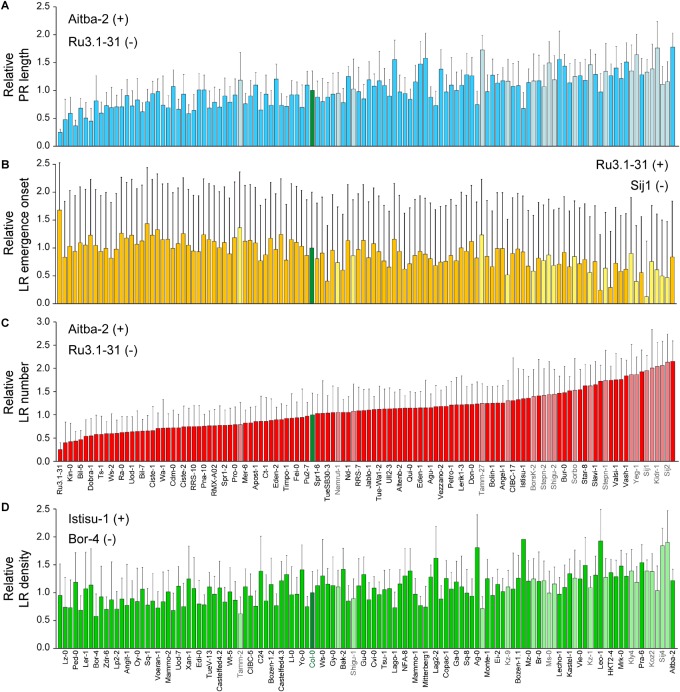
Natural variation of LR architecture after root tip excision in 120 accessions of Arabidopsis thaliana. Average ± standard deviation (SD) values of (A) relative PR length, (B) relative LR emergence onset, (C) relative LR number, and (D) relative LR density at 4 dae as compared with the Col-0 reference accession. Light-colored bars indicate accessions belonging to the “East” subpopulation (names indicated in gray). The Col-0 reference is shown in green. Accessions are sorted based on their relative LR numbers. Those accessions with extreme phenotypes (+, maximum; −, minimum) are also indicated.